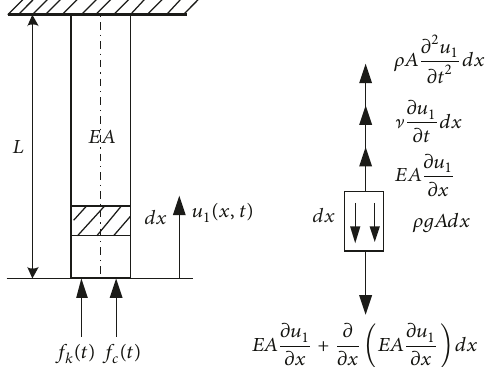
Figure 4: Mechanical analysis of an oil tube